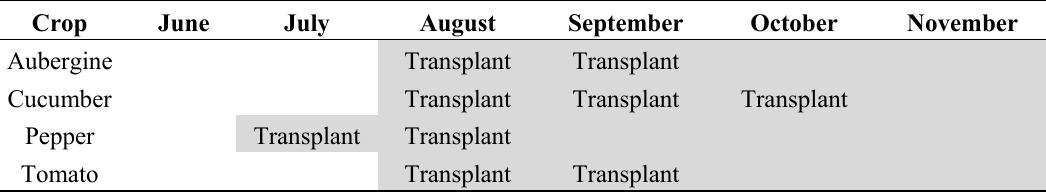
Table 2. Schematic summary of the typical transplant pattern for the four studied crops.